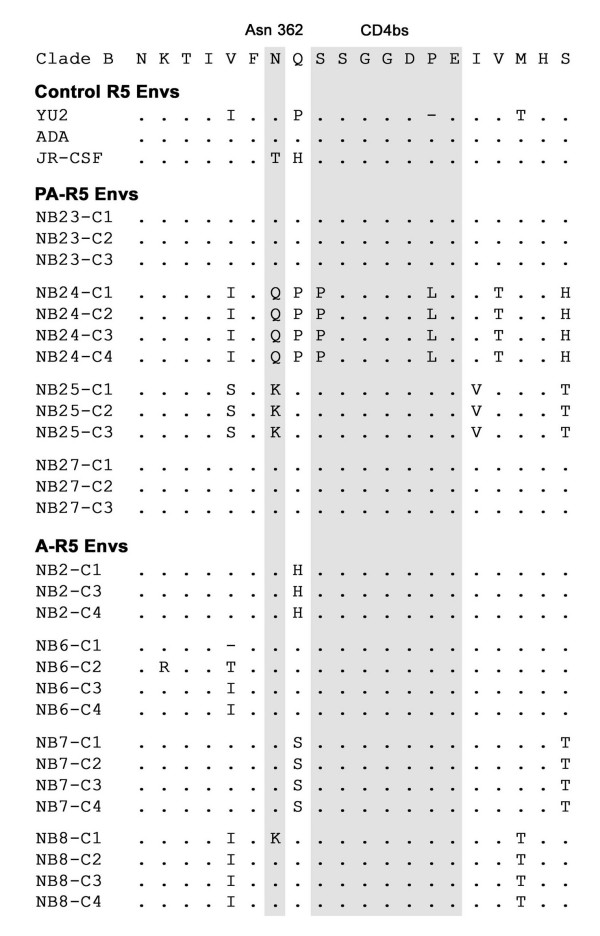
Amino acid sequences spanning the CD4bs in the C3 region of gp120. Amino acid alignments of the C3 region of PA-R5 and A-R5 Envs cloned from the cross sectional panel of primary HIV-1 isolates are compared to those from the highly fusogenic YU2 and ADA R5 Envs, the poorly fusogenic JR-CSF R5 Env, and the clade B consensus sequence. Dots indicate residues identical to the clade B consensus sequence, and dashes indicate gaps. Residues forming the CD4bs and the amino acid present at position 362 (numbered relative to the HXB2 reference sequence) are highlighted.